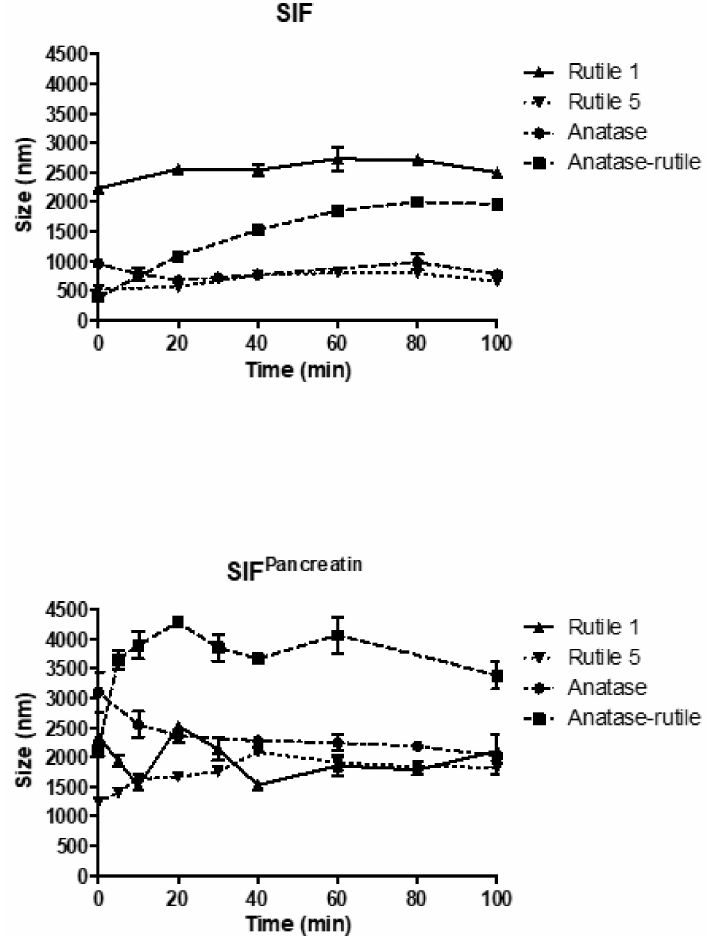
Figure 6. Time-dependent change in particle size of TiO 2 particles in simulated intestinal fluid. The starting concentration of the TiO 2 particles was 0.5 mg/mL dispersion